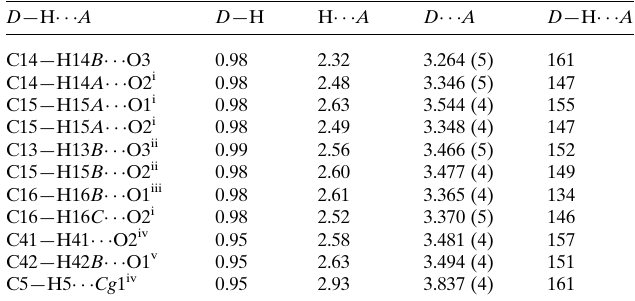
Table 1 Hydrogen-bond geometry (A˚ , (cid:4) ). Cg 1 is the centroid of the C1–C6 benzene ring.